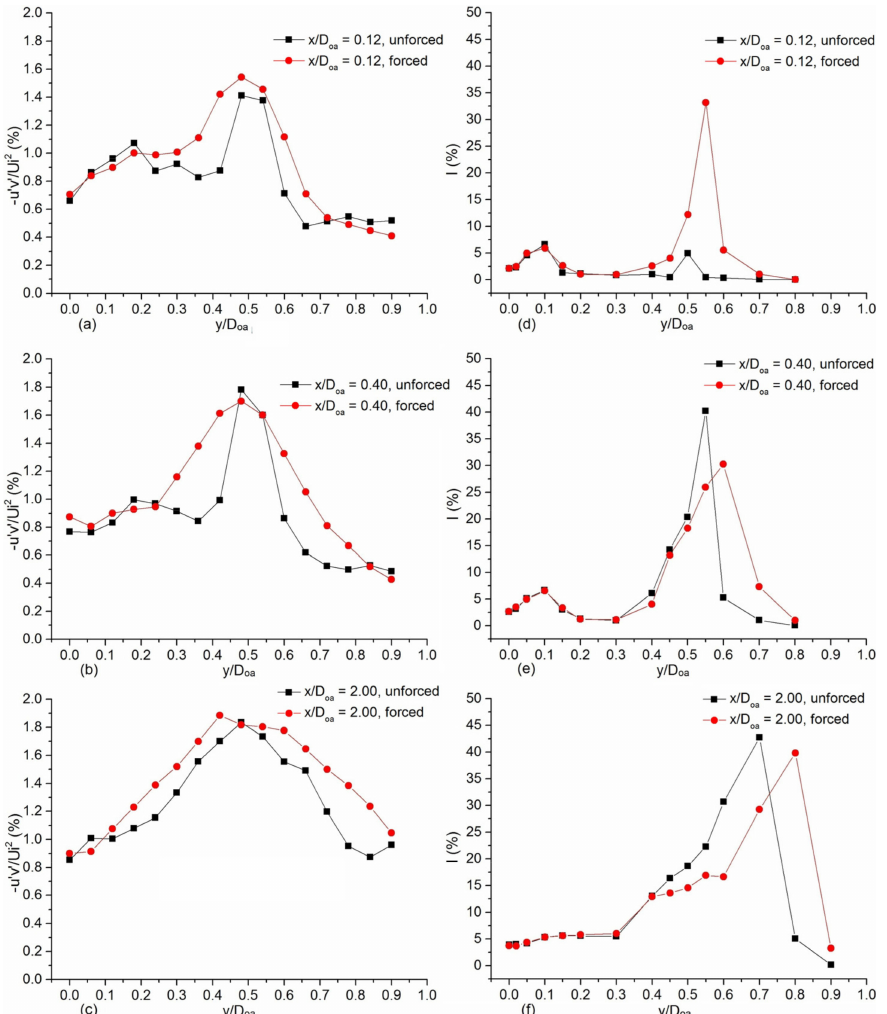
Figure 5. The radial distribution of Reynolds shear stress ( a – c ) and turbulence intensity ( d – f ) at different axial positions of nozzle